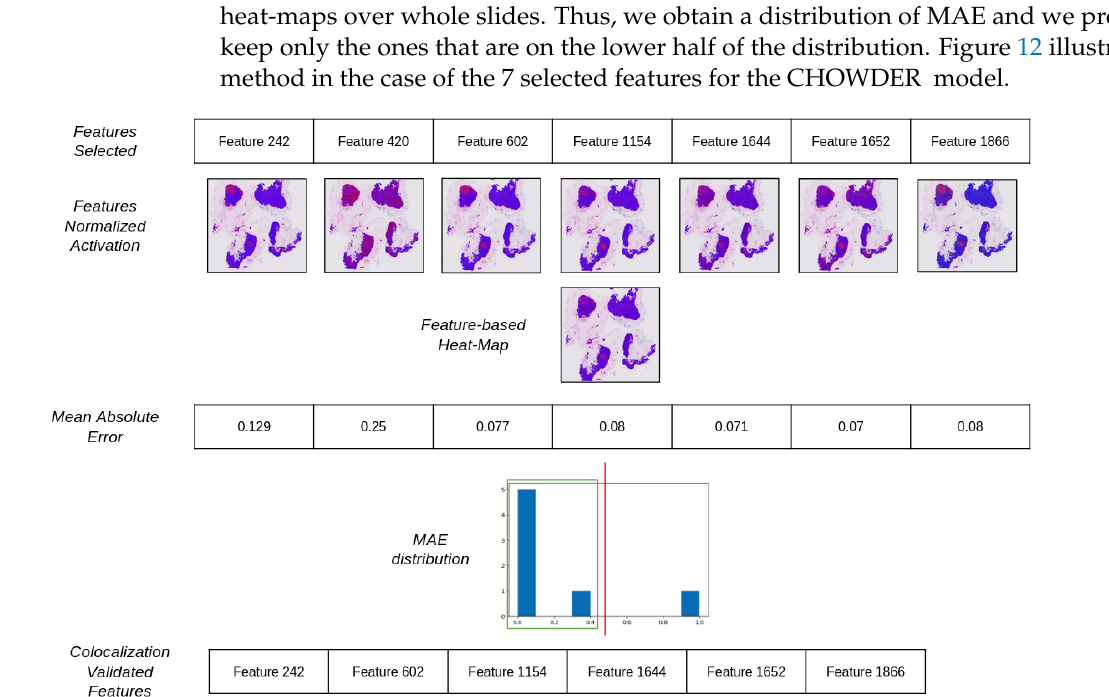
Figure 12. Illustration of the colocalization filtering method.